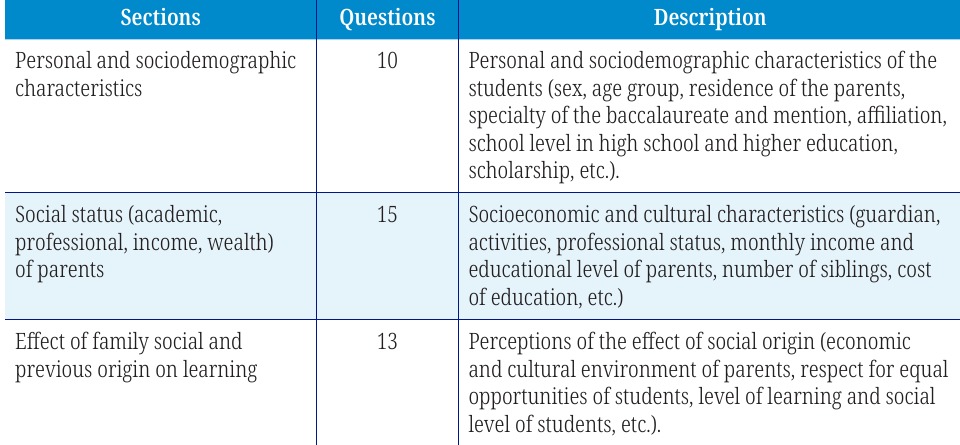
Table 2. Distribution of the